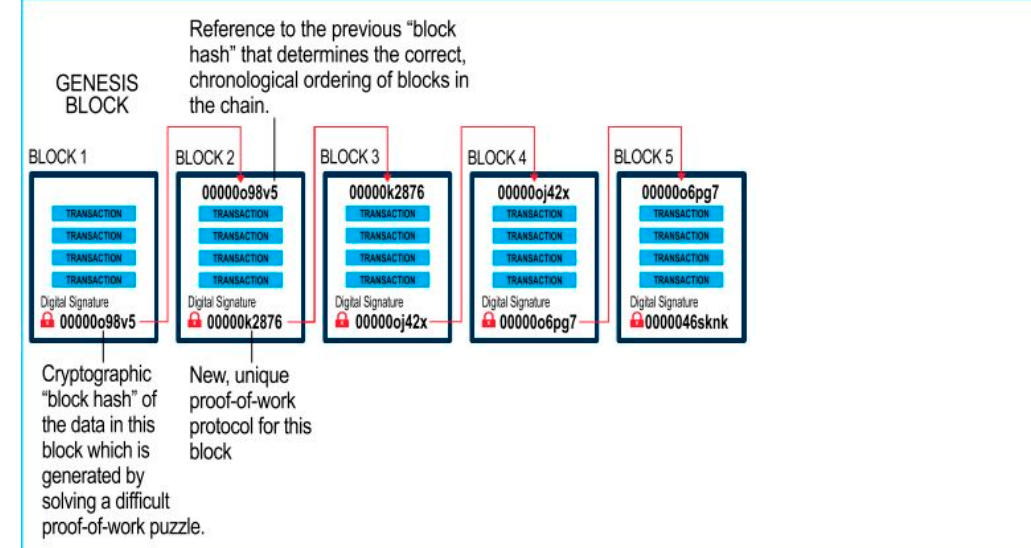
Figure 1. Blockchain transaction process. Source: [23].